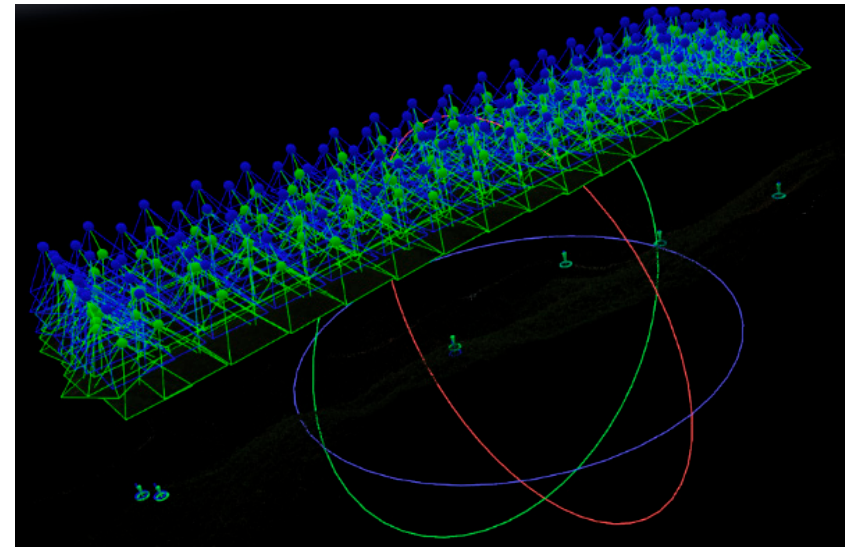
Figure 5. Data processing of the 132 RGB images in Pix4D (SfM), where dots in blue and green represent the individual photos and their overlap. GCPs are shown below.